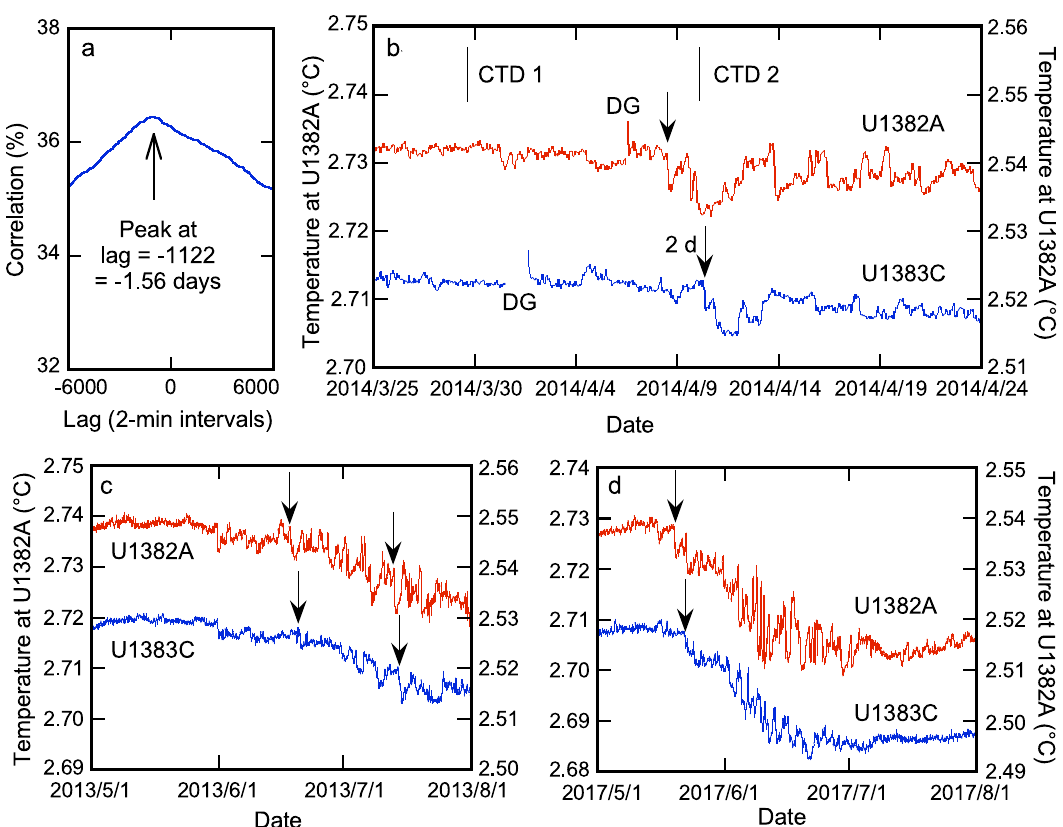
Fig. 4 Correlation function and example time lags between bottom-water temperatures at Holes U1382A and U1383C. a The correlation function between temperatures at the two holes as a function of time lag. b One month record of in-situ bottom water temperatures at Holes U1382A and U1383C from late March to late April, 2014, spanning the early April cooling event and two CTD casts. DG = data gap on data download, with brief spike on resumption of data logging. c , d Expanded three-month views of the major decreases in bottom-water temperatures in 2013 and 2017, respectively, illustrating typical 2- to 3.5-day lags of events at Hole U1383C. In b – d , the U1382A temperature record is shown in red, the U1383C record is shown in blue, and vertical arrows indicate example events seen at both